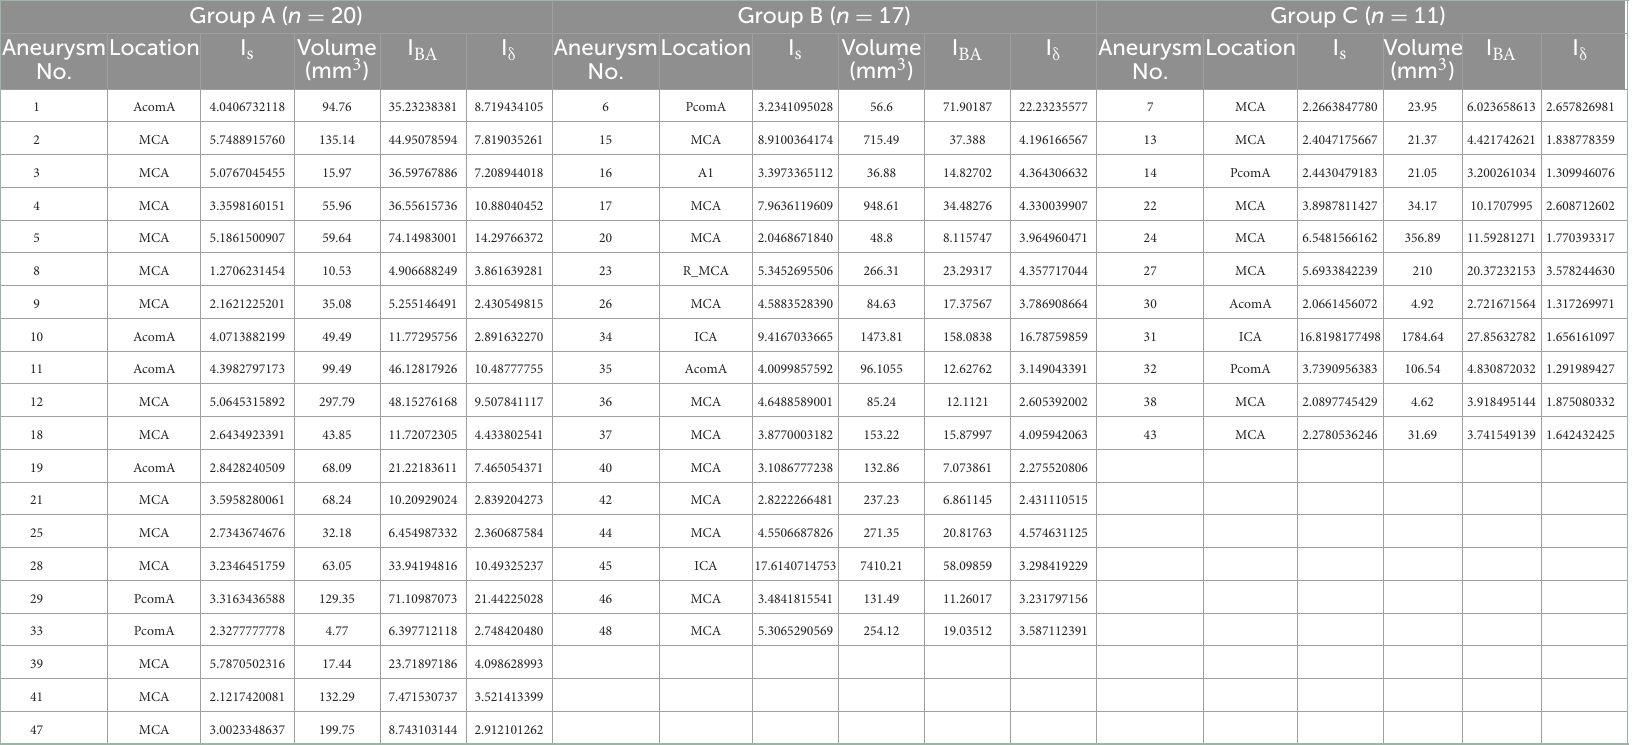
TABLE 1 Basic information and original data of parameters of 48